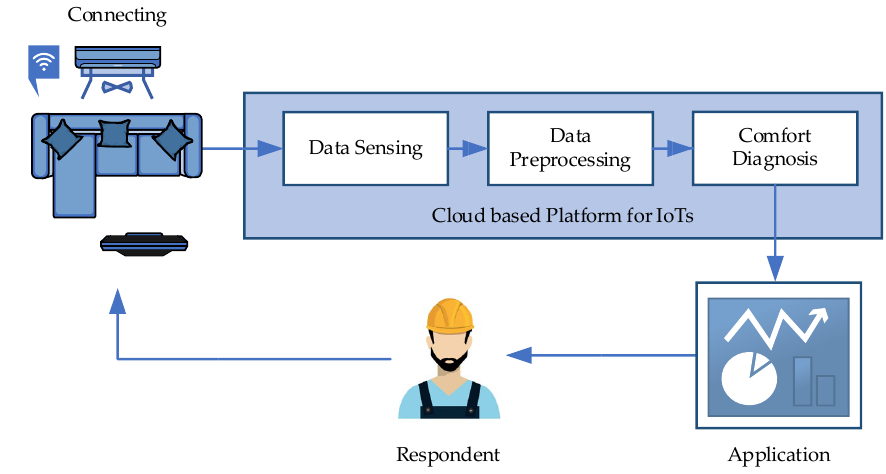
Figure 1. Overview architecture of fault detection and diagnosis of thermal comfort . Figure 1 consists of five components: (1 ) home connecting, (2 ) data sensing, (3 ) data preprocessing, (4 ) comfort interpreting, and (5 ) application . Home connecting represents